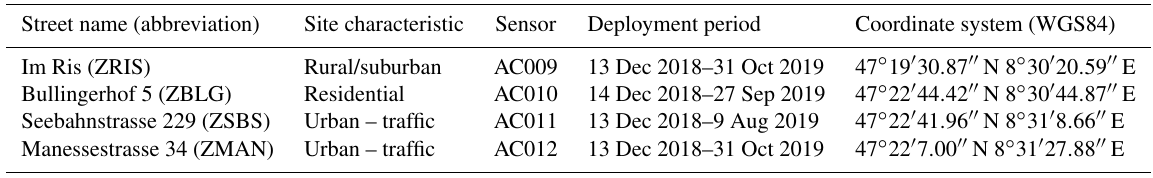
Table 1. Four deployment sites of low-cost sensors. The coordinate system refers to the world geodetic system, WGS84, obtained from the geo-mapping platform of the Swiss Confederation. © Swisstopo